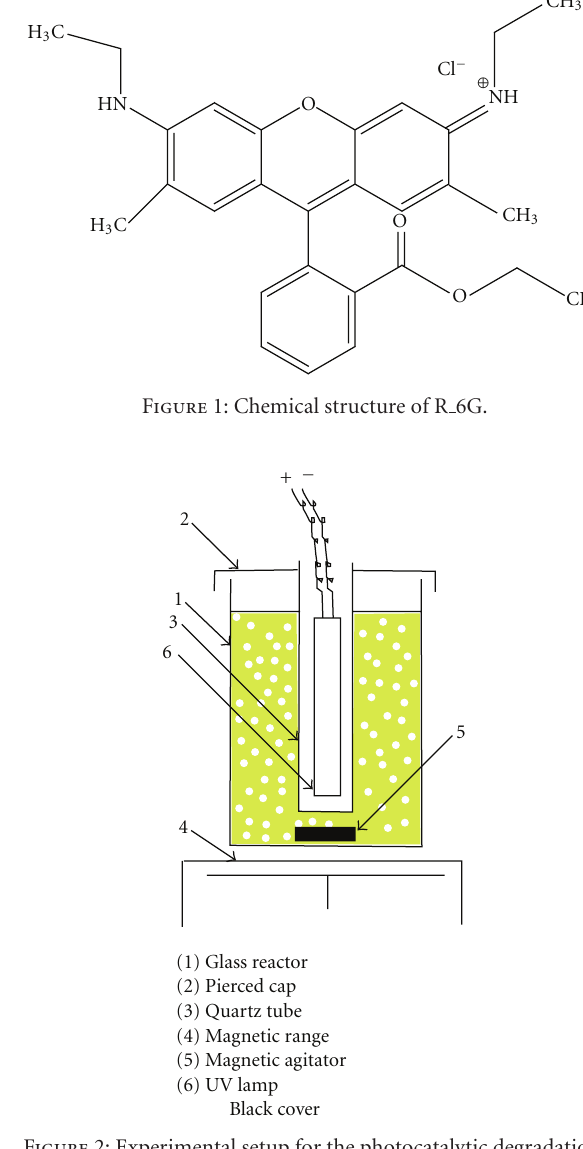
Figure 2: Experimental setup for the photocatalytic